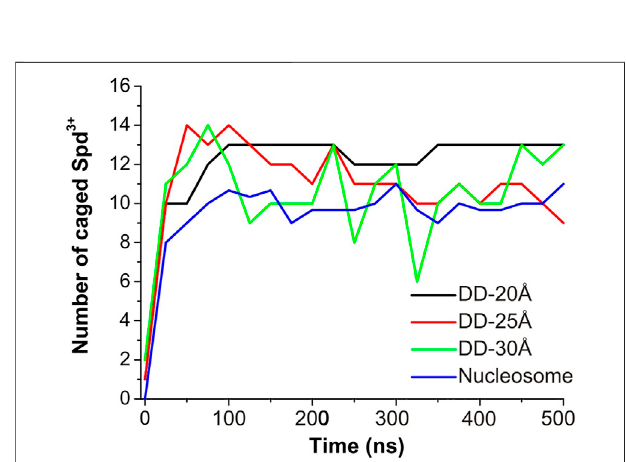
FIGURE 7 | Evolution of the number of Spd 3+ caged between parallel DNA molecules (or molecular portions). In the case of the nucleosomal system, the total number of Spd 3+ has been normalized to match the other